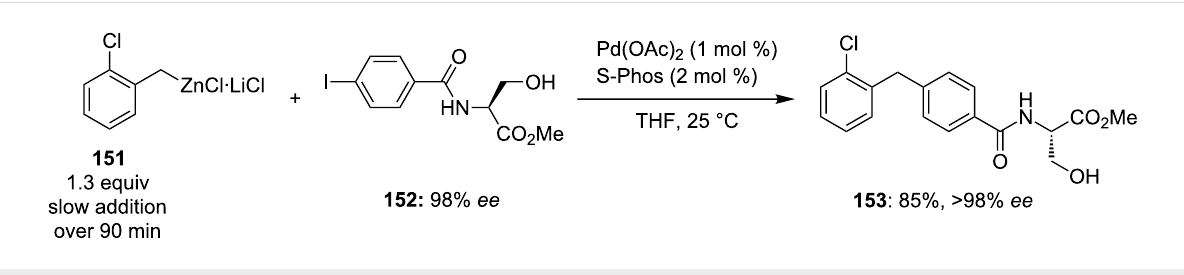
Scheme 23: Negishi cross-coupling in the presence of a serine moiety.